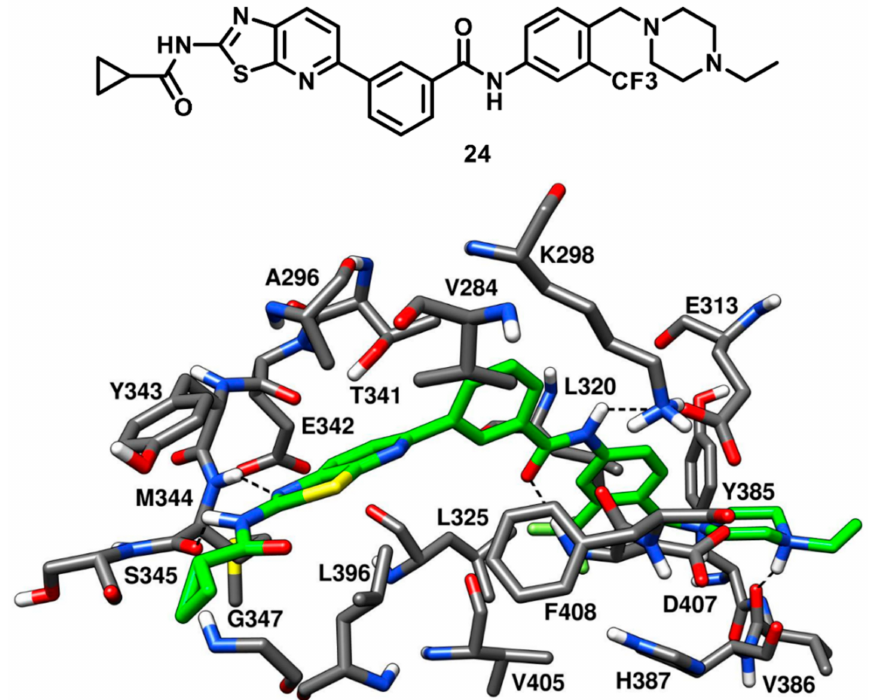
Figure 20. 2D structure of 24 . X-ray structures of c-Src kinase in complex with 24 (PDB ID: 4AGW). Active site residues of c-Src kinase and the enzyme–inhibitor H-bond interactions are